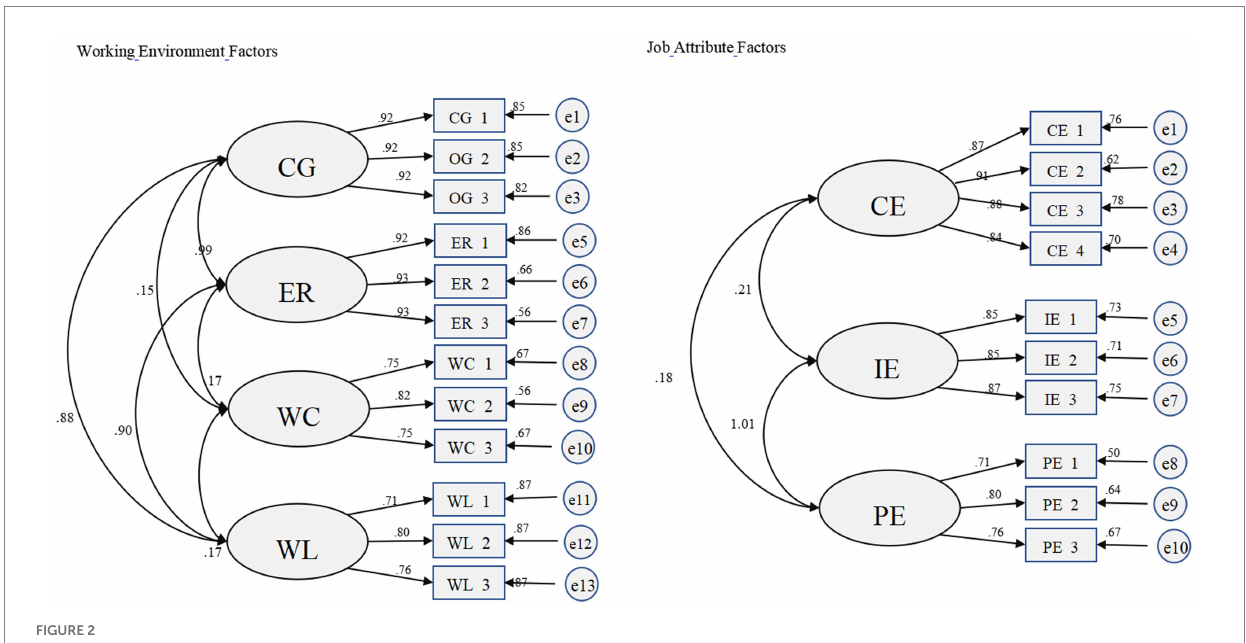
FIGURE 2 Standardization of each factor of overtime